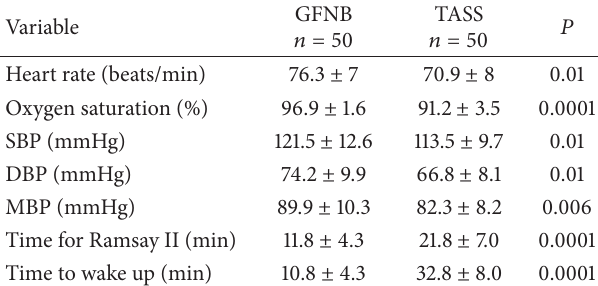
Table 2: Hemodynamic variables during upper gastrointestinal endoscopy in relation to